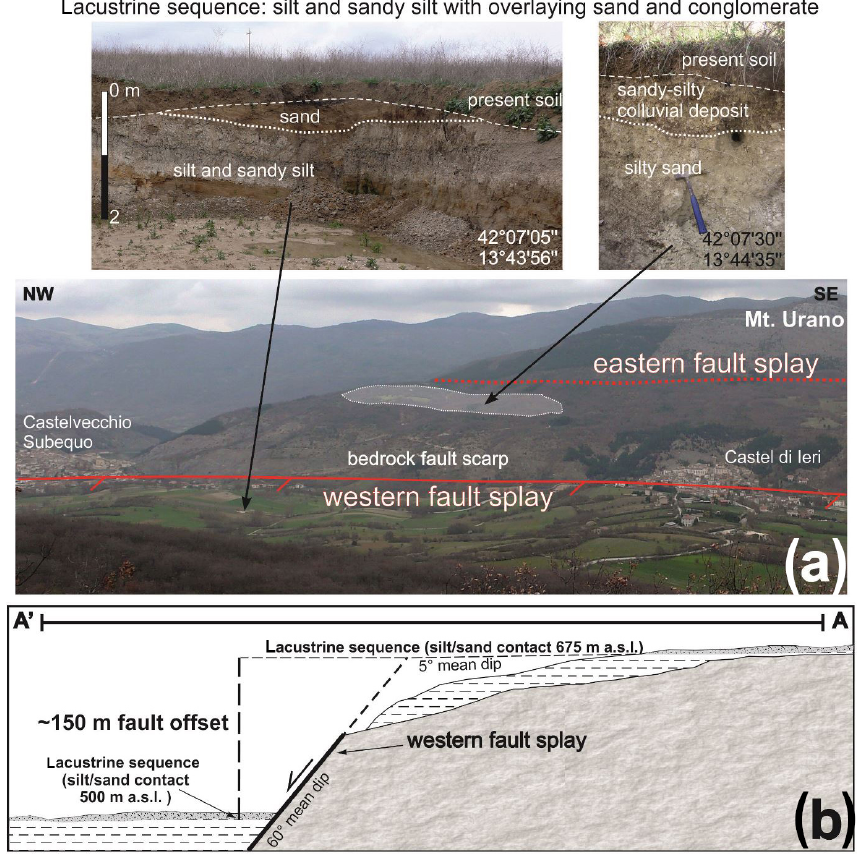
Figure 3. (a) Panoramic view of the southwestern slope of Mt Urano; major normal fault splay of the Subequana Valley fault, red lines; outcrops of the upper lacustrine sequence of the Subequana Valley are pointed by arrows and shown in insets. (b) Schematic geological cross section showing the displacement of the Subequana Valley lacustrine deposits across the western splay of the fault (see Fig. 2 for the section